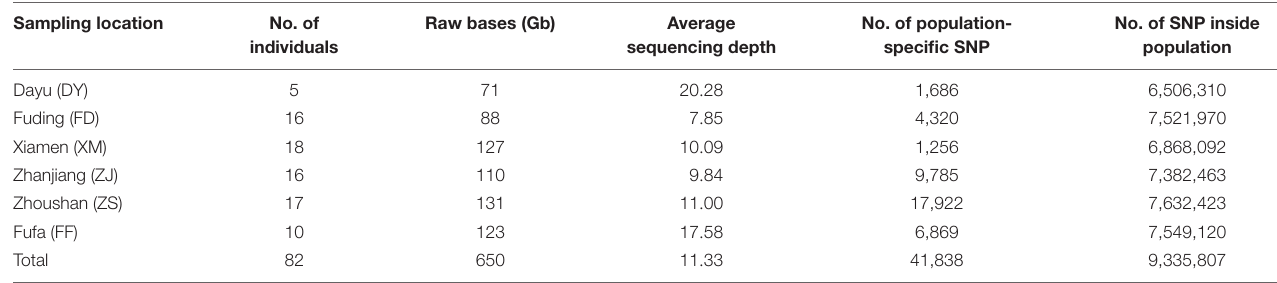
TABLE 1 | Genome re-sequencing and SNP calling for the wild and cultured population of large yellow croakers. Sampling